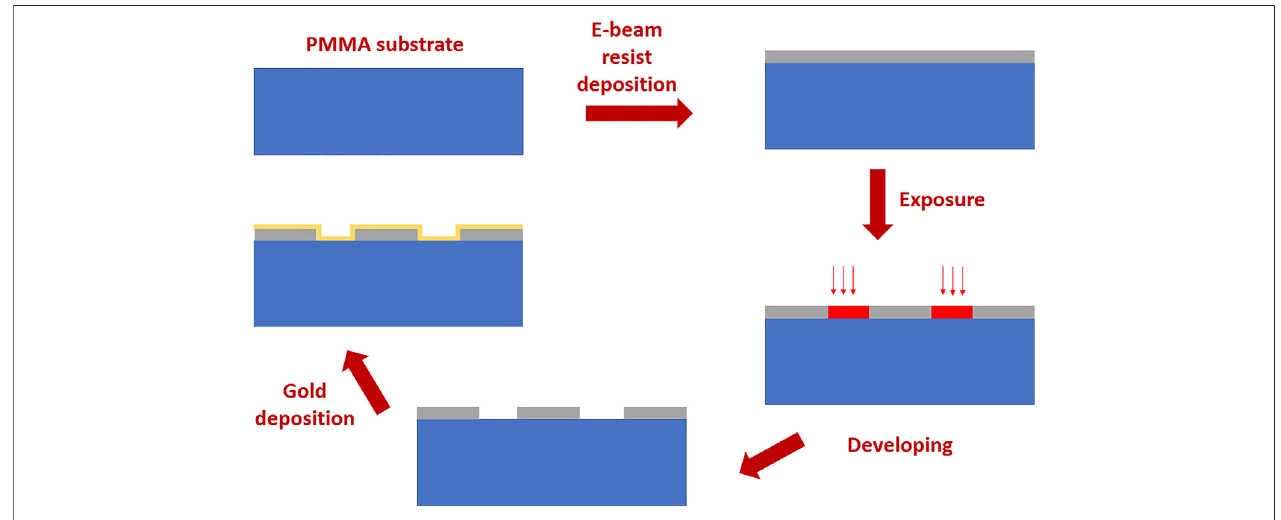
FIGURE 1 | Fabrication steps to realize the gold nanograting based on